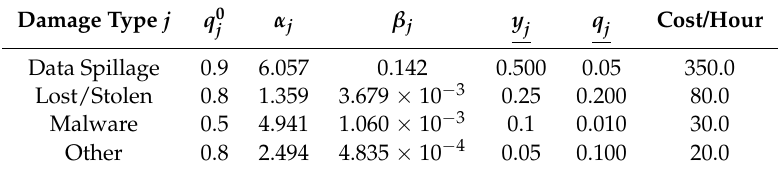
Table 2. Summary of assumptions on attacks. The q 0 attack in the absence of spending on mitigations. The parameters α j and β j are found from q 0 and ˆ r j in Table 1 using Equation (1). Finally, y j is a floor on the amount of damage an attack can inflict and q j is a floor on the probability of successful attack, as in Equations (10) and (11).